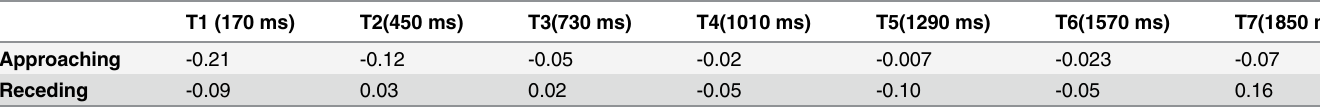
Table 1. Slopes of the tangent lines evaluated at the 7 time